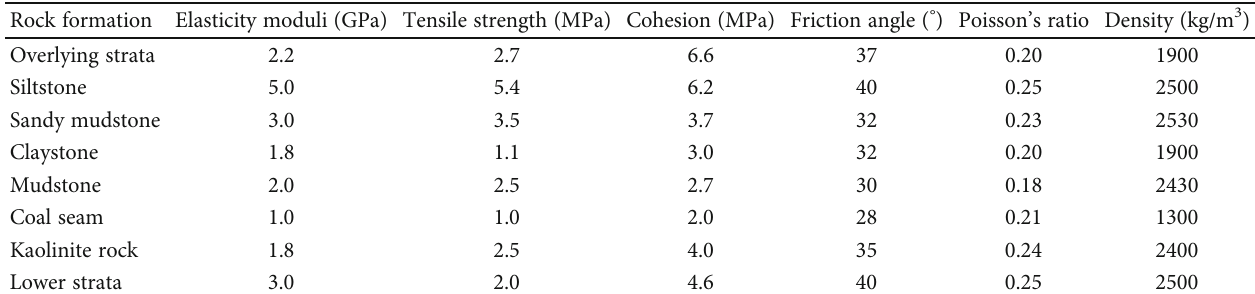
Figure 3: Numerical simulation fl owchart. Table 2: Physicomechanical parameters for each rock